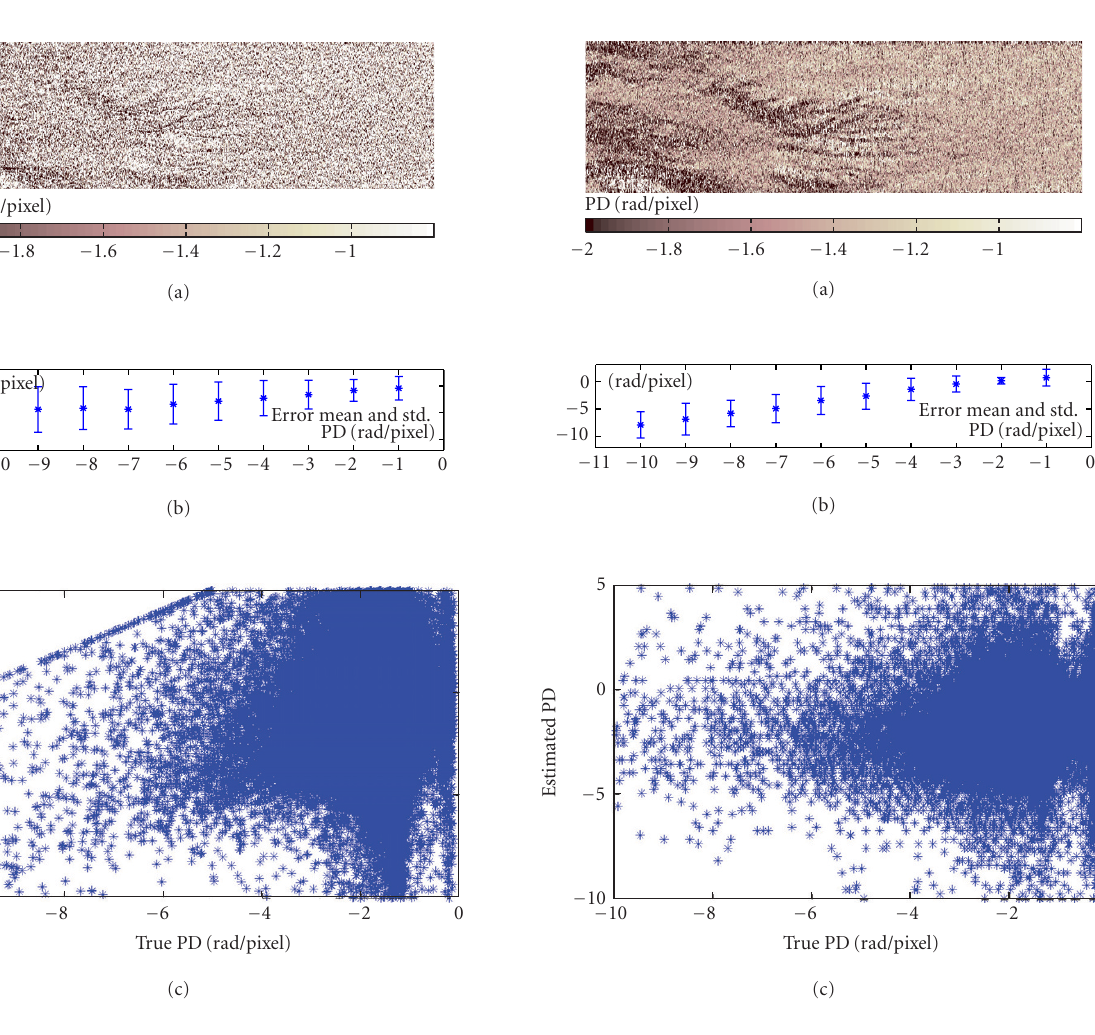
Figure 9: the error bar plot is horizontal, although there